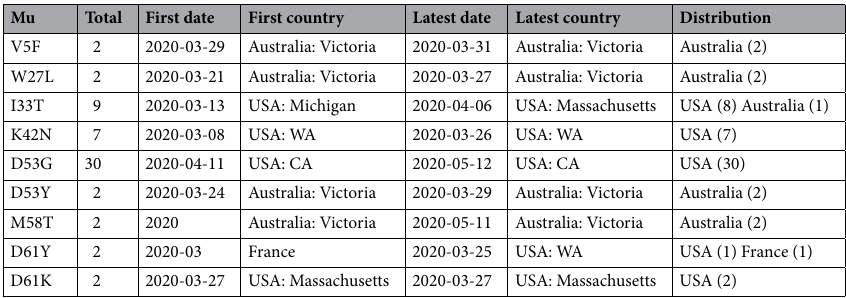
Table 5. Gene ORF6—nonsynonymous mutations occurring in 2 or more sequences.